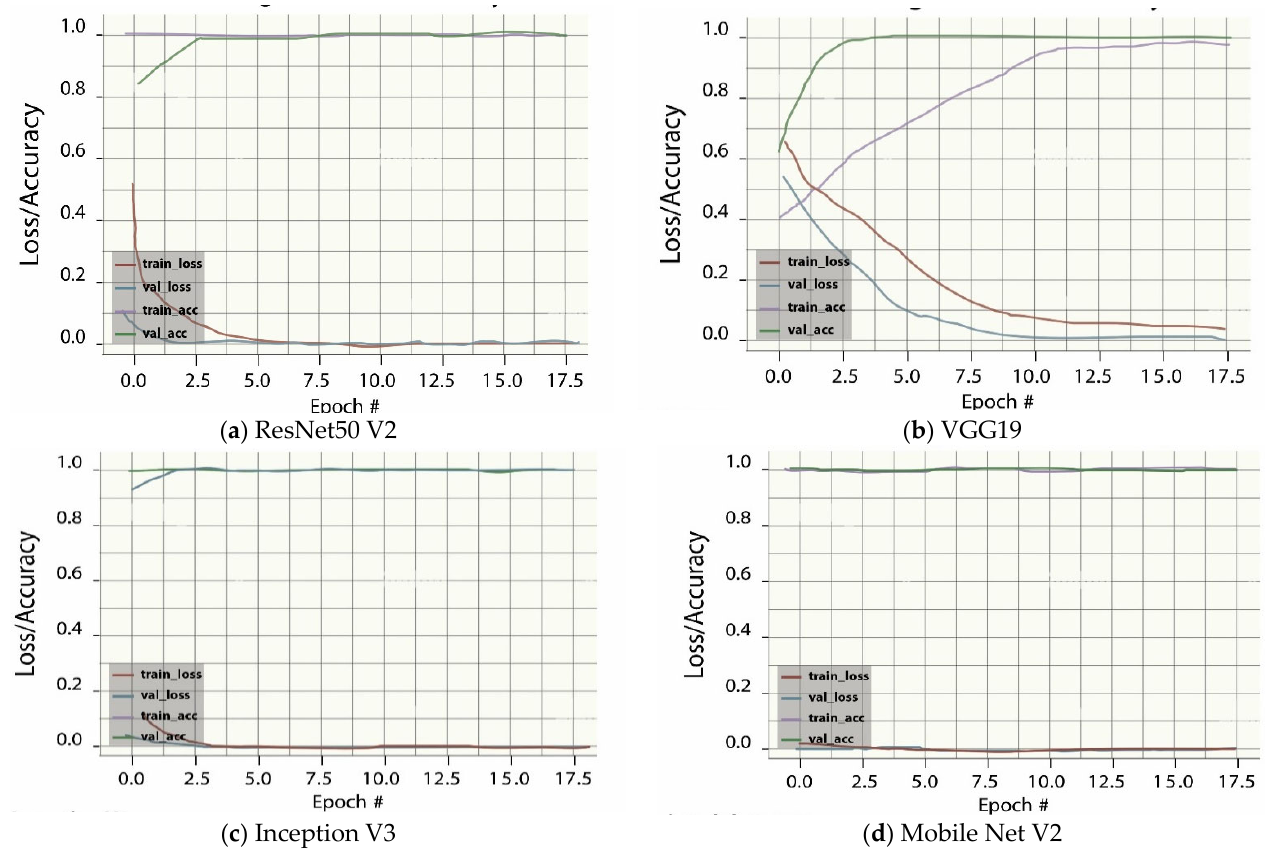
Figure 6. Accuracy and loss of face mask detection in different models.